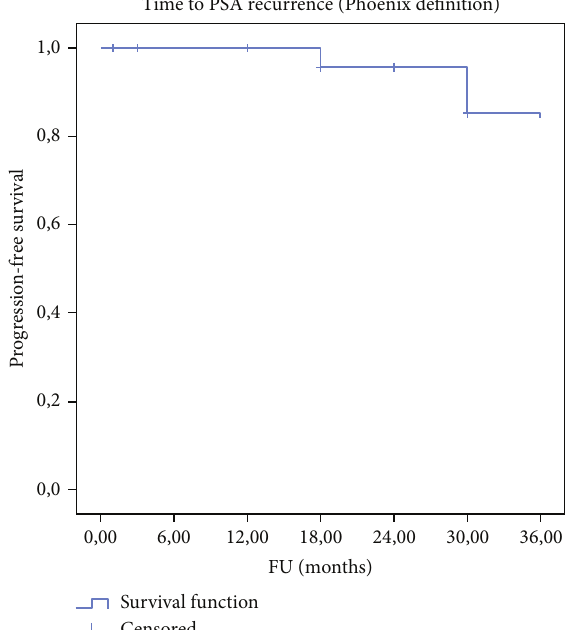
Figure 2: Biochemical progression-free survival (Phoenix definition-Nadir + 2ng/mL).